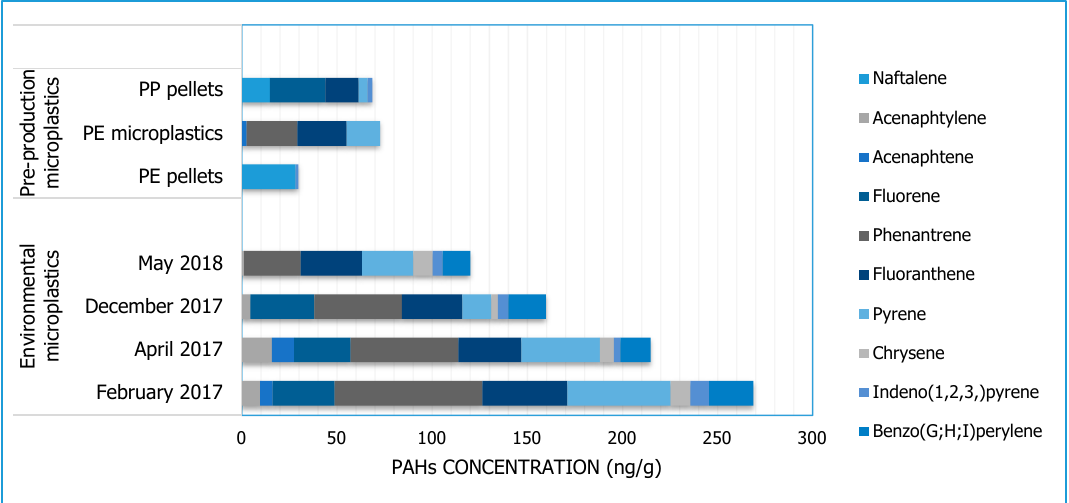
Figure 2. Concentrations of 16 EPA-PAHs, expressed as ng / g, registered on environmental MPs (April 2017, February 2017, December 2017, May 2018) and on virgin MPs (virgin PE, virgin coloured PE, virgin PP). Virgin PE and PP were colourless pellets while Virgin coloured PE was green microparticles (<500 μ m).